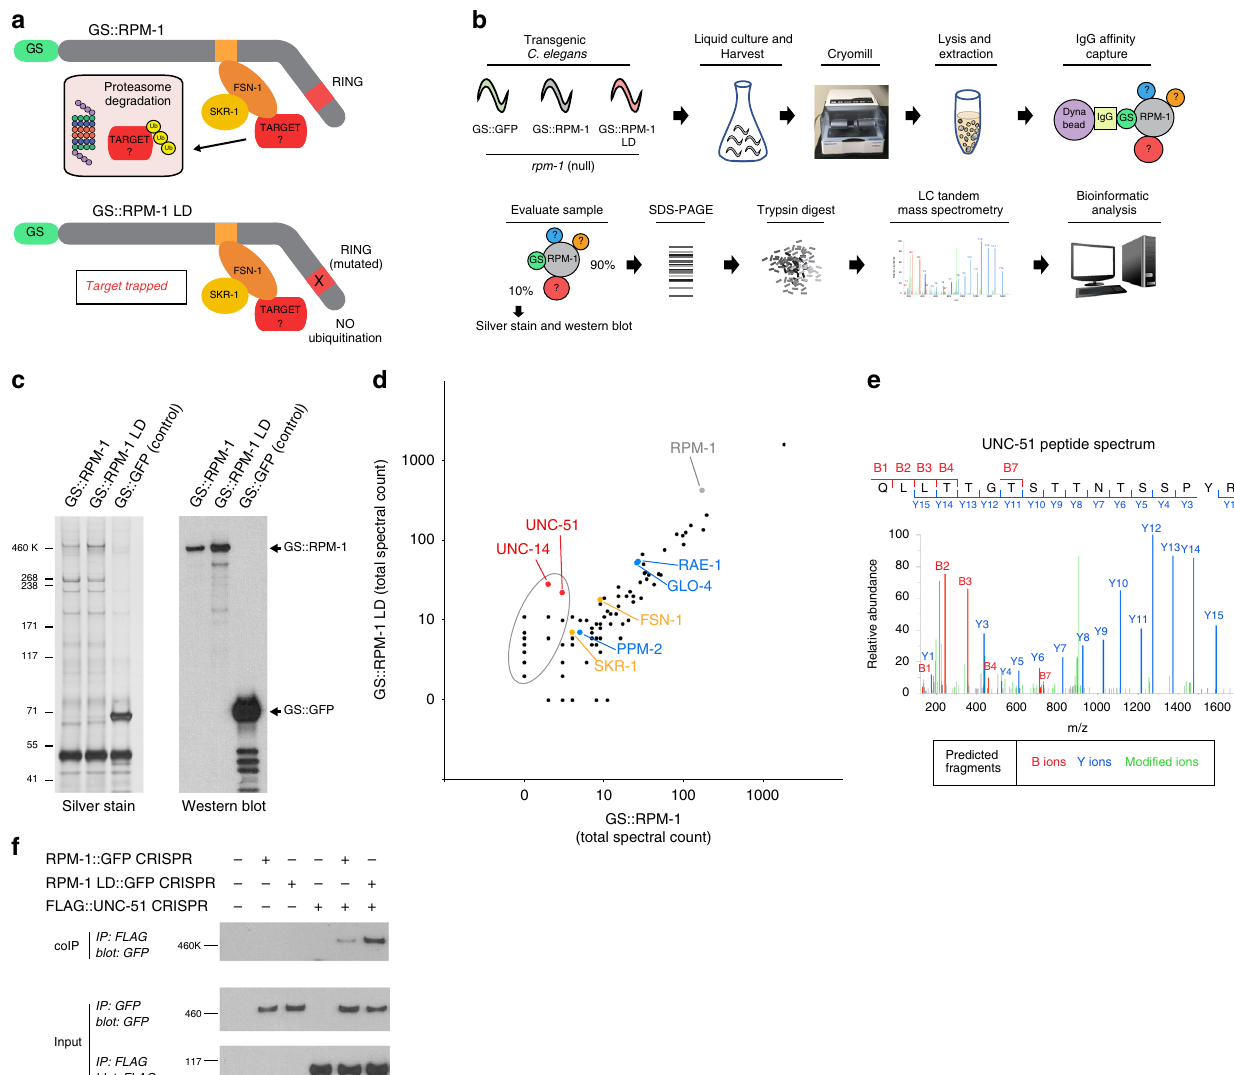
Fig. 1 Af fi nity-puri fi cation proteomics from C. elegans identi fi es UNC-51 as a putative RPM-1 ubiquitination substrate. a Schematic showing RPM-1 ubiquitin ligase complex, RPM-1 constructs used for proteomics, and RPM-1 LD point mutant that enriches ubiquitination substrates. b Experimental work fl ow for af fi nity-puri fi cation proteomics from C. elegans . c Example of silver stain (left) and anti-SBP western blot (right) used to evaluate GS::RPM-1, GS::RPM-1 LD, and GS::GFP samples puri fi ed from C. elegans extracts. d Representative example of a single proteomics experiment showing the total spectral counts for individual proteins identi fi ed by LC-MS/MS. Shown are the results for GS::RPM-1 LD sample compared with GS::RPM-1 sample with nonspeci fi c hits found in GS::GFP negative control samples above threshold level removed. Highlighted are proteins enriched in RPM-1 LD (gray oval) including UNC-51 and UNC- 14 (red), known RPM-1-binding proteins (blue), and RPM-1 ubiquitin ligase complex components (orange). e Example of LC-MS/MS peptide spectrum for UNC-51 identi fi ed in GS::RPM-1 LD sample. f CoIP from C. elegans CRISPR strains shows more binding of RPM-1 LD::GFP than RPM-1::GFP to